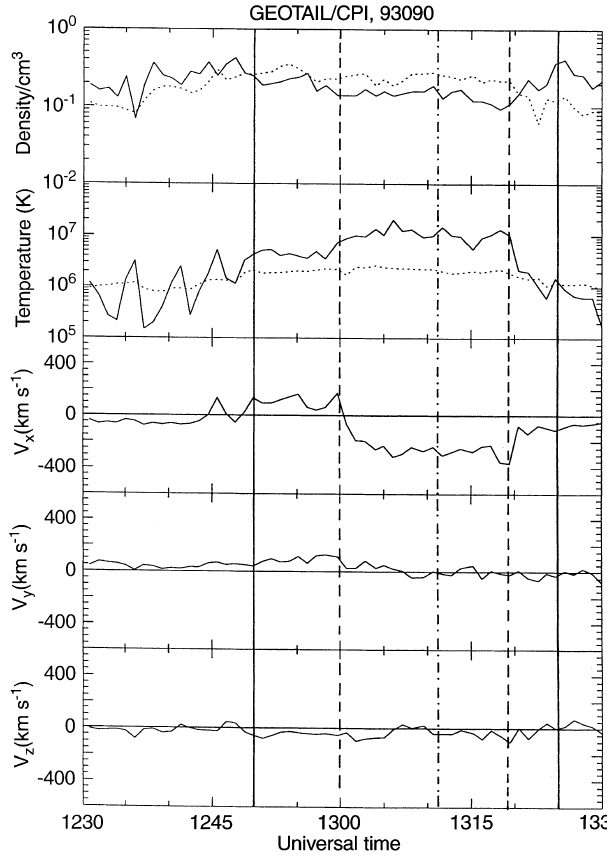
Fig. 6. The KP parameters of number densities and temperatures for protons ( solid line ) and electrons ( dashed line ) are shown in the upper two panels for the flux rope signature centred at (cid:24) 1307 UT on March 31, 1993. The components of proton bulk flow are shown in the lower three panels . The vertical lines are plotted as in